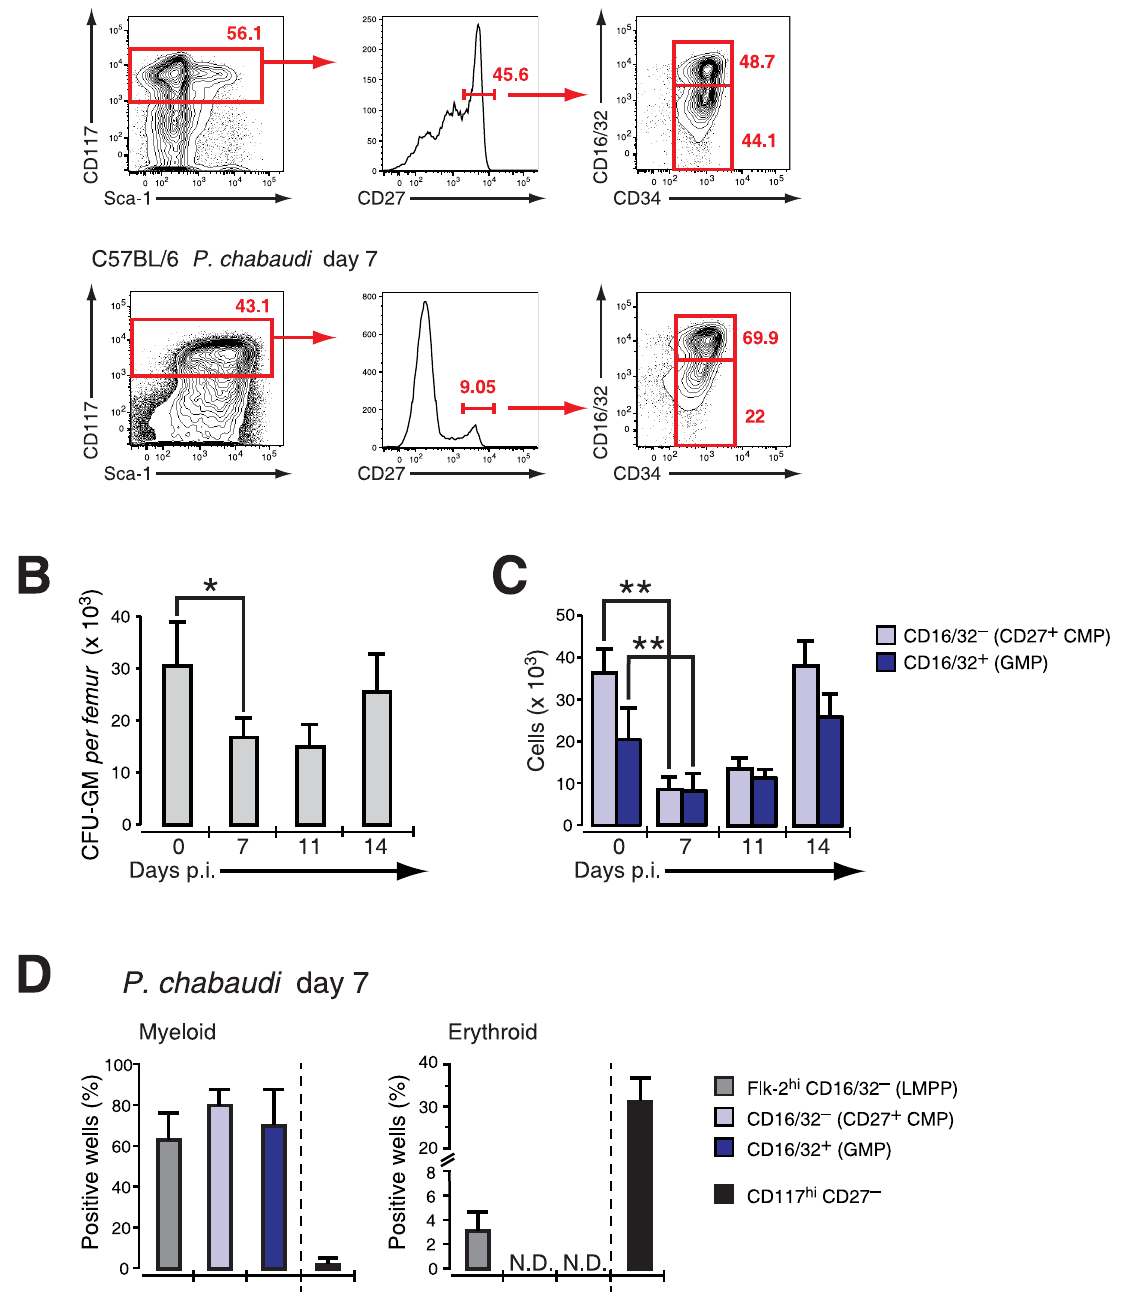
Figure 3. Effect of acute infection with P.chabaudi on myeloid progenitor cells in the bone marrow. Infection of C57BL/6 female mice (6– 8 weeks) with P. chabaudi resulted in a transient decrease of myeloid lineage progenitors in the bone marrow (BM) during acute infection. A. BM cells from uninfected controls and malaria-infected animals at day 7 of infection with P. chabaudi were co-stained with antibodies against lineage markers, Sca-1, CD117 (c-Kit), CD27, CD34, CD16/32 (Fc c RII/III) and separated as indicated. Doublets were electronically excluded prior to analysis. Data are representative for 19 infection experiments with numbers in individual plots indicating the frequency (in %) of the respective population. B. Analysis of granulocyte-monocyte colony forming units in semi-solid media from total BM during acute malaria. Data are from two experiments with 4–5 BM samples per experiment and shown as mean 6 SEM of total number of CFU-GM per femur (*: P # 0.05, two-tailed Student’s t -test). C. Absolute cell numbers of the CD27 + CMP (light blue bars) and the GMP (blue bars) progenitor populations during the course of a malaria infection. Data represent mean 6 SEM of cell number per femur/pair obtained from 19 infection experiments with 4–5 mice per group (**: P # 0.01, Mann-Whitney U-test). D. Single cell in vitro cultures that support myeloid or erythroid differentiation of FACS purified hematopoietic BM progenitors obtained at day 7 after infection with P. chabaudi . Data are shown as mean 6 SEM of individual positive wells (in %) of three infection experiments with 5 mice per subset (N.D.=not detected).